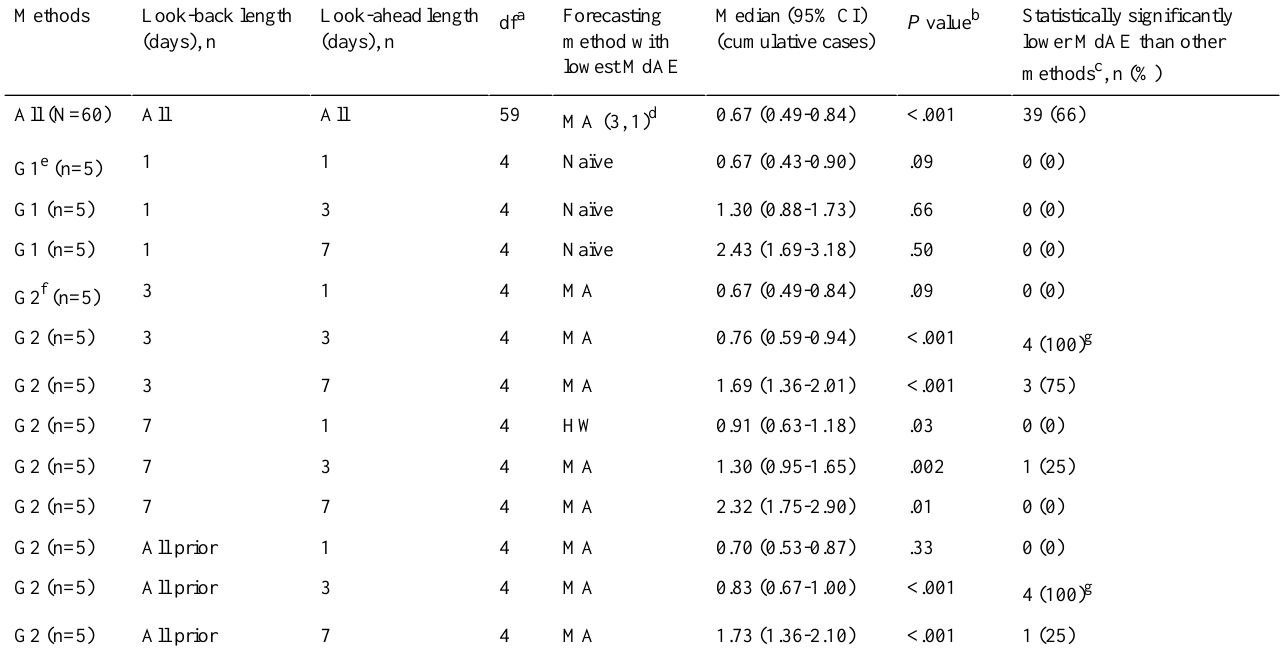
Table 1. County-level median absolute error (MdAE) outcomes by forecasting method, look-back length, and forecast